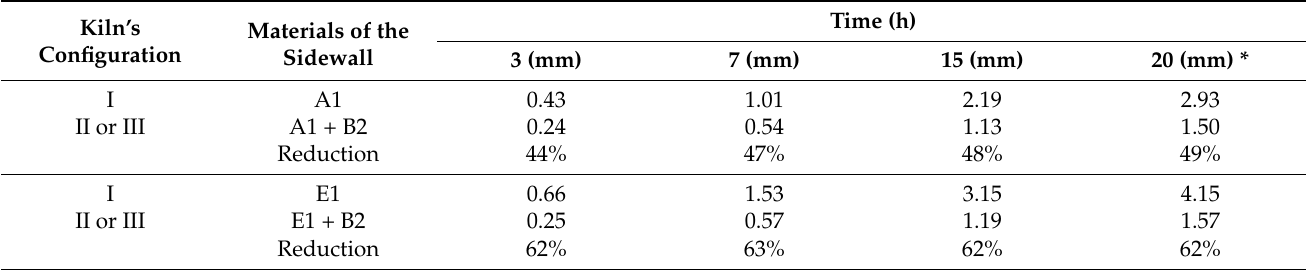
Table 10. Reduction in heating time for sidewall A1 + B2 or E1 + B2 (configuration II or III) compared